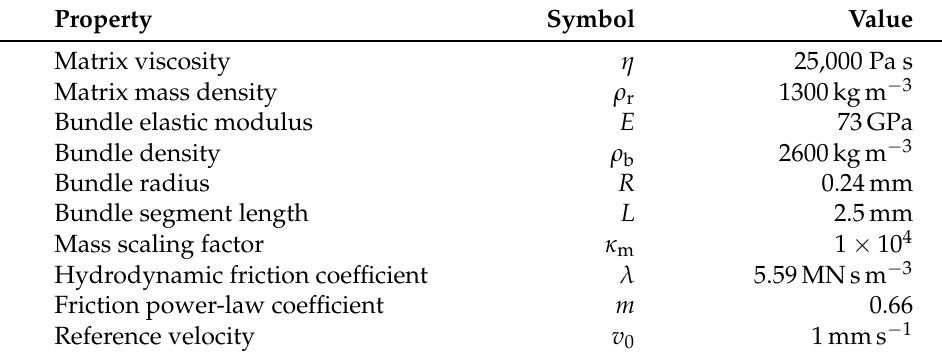
Table A4. Direct bundle simulation